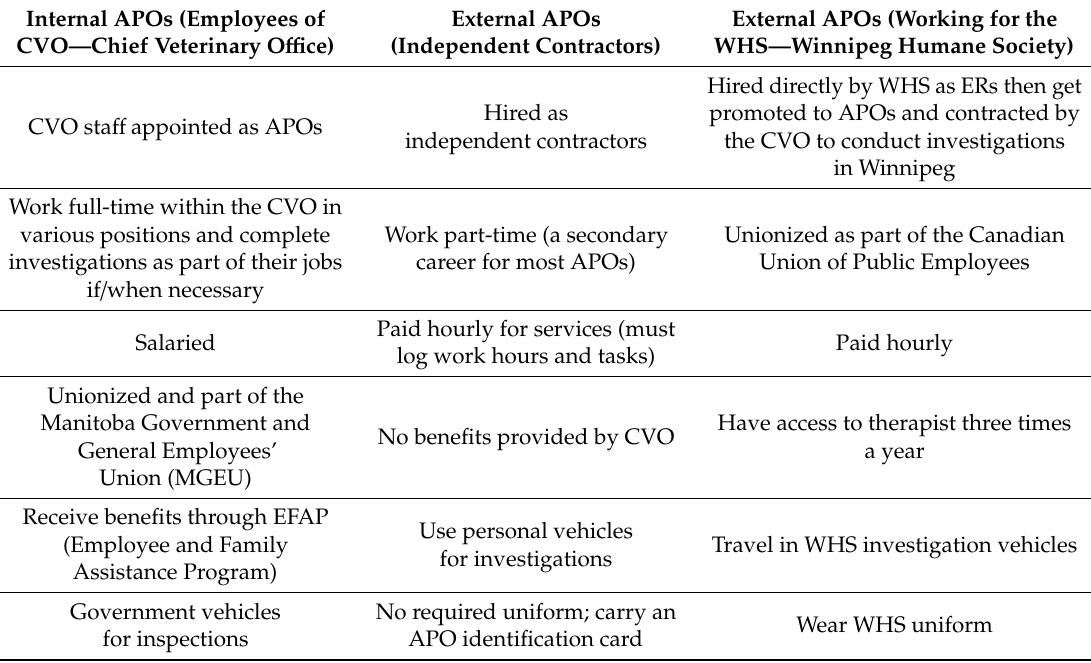
Table 1. Comparing Types of APOs in